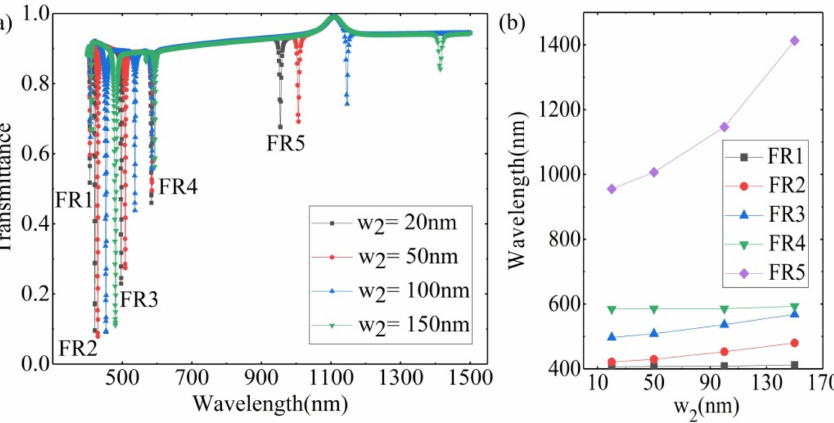
Figure 9. ( a ) The transmittance spectra of different w 2 ; ( b ) the resonance wavelength of FR1, FR2, FR3, FR4 and FR5 with different w 2